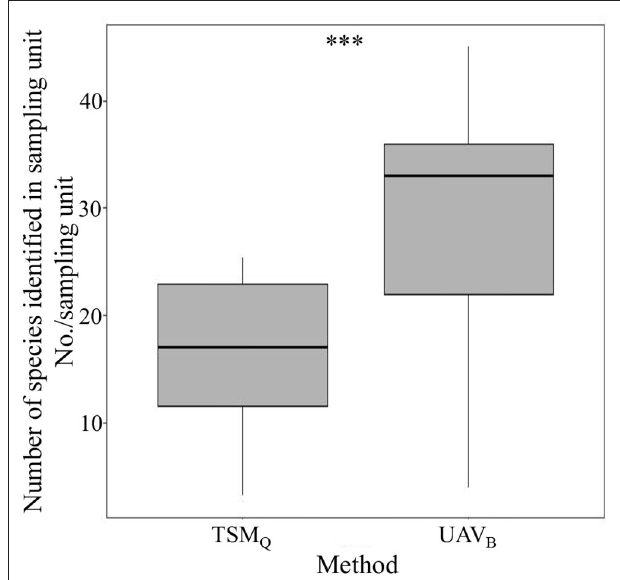
FIGURE 3 | The number of species identified within the sampling unit by the traditional sampling method (TSM Q ) and the UAV-based method (UAV B ). ***Indicates significant difference at P < 0.001